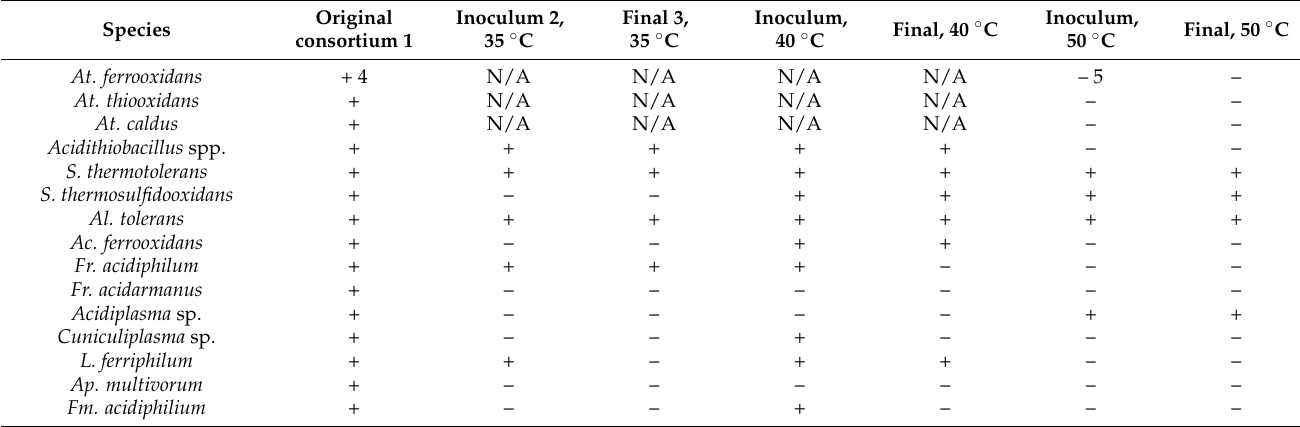
5 –, absent. Abbreviations: N/A, not available; At. Acidithiobacillus ; S. Sulfobacillus ; Al. Alicyclobacillus ; Ac. Acidibacillus ; Ap. Acidiphilium ; Fr. Ferroplasma ; Fm. Ferrimicrobium